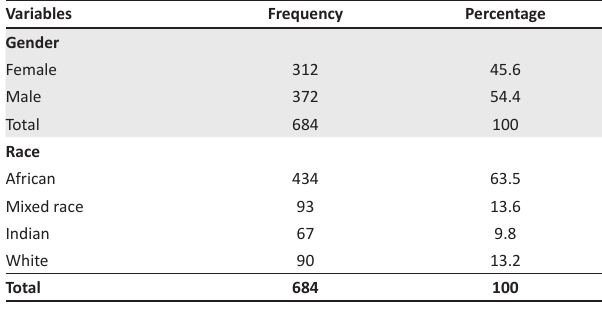
TABLE 2: Socio-demographic